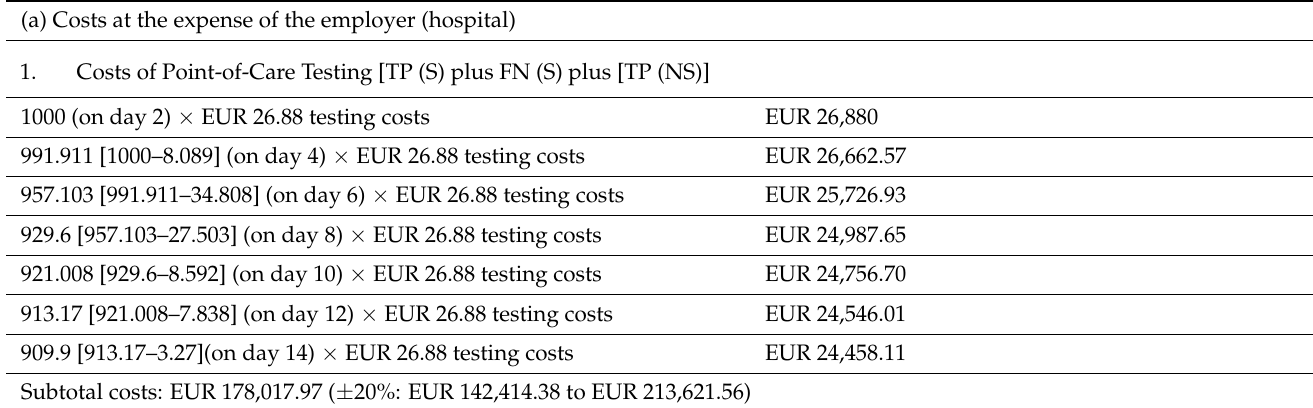
Table 4. Costs of allowing HCW to work (per 1000 exposed